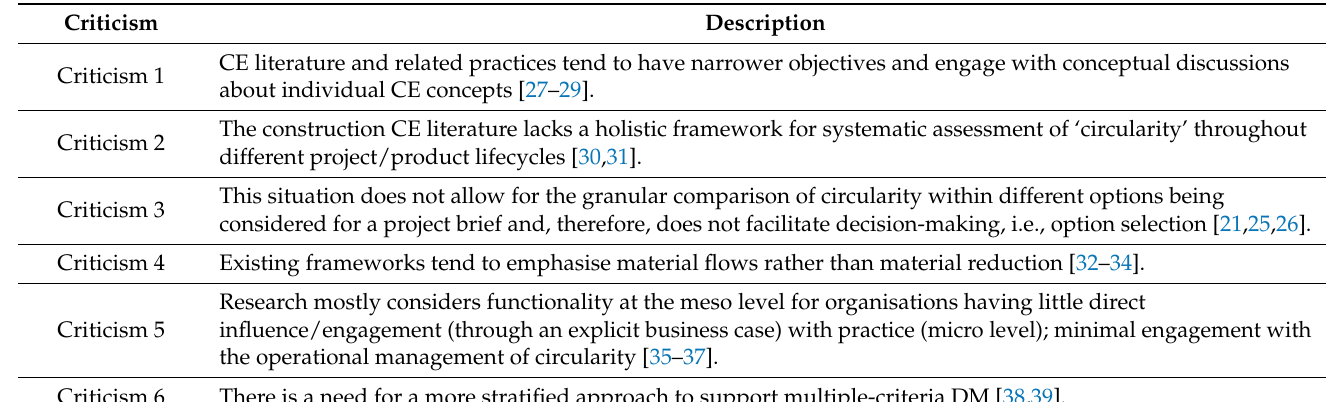
Table 1. Six criticisms of the CE literature from the circularity assessments (CAs)